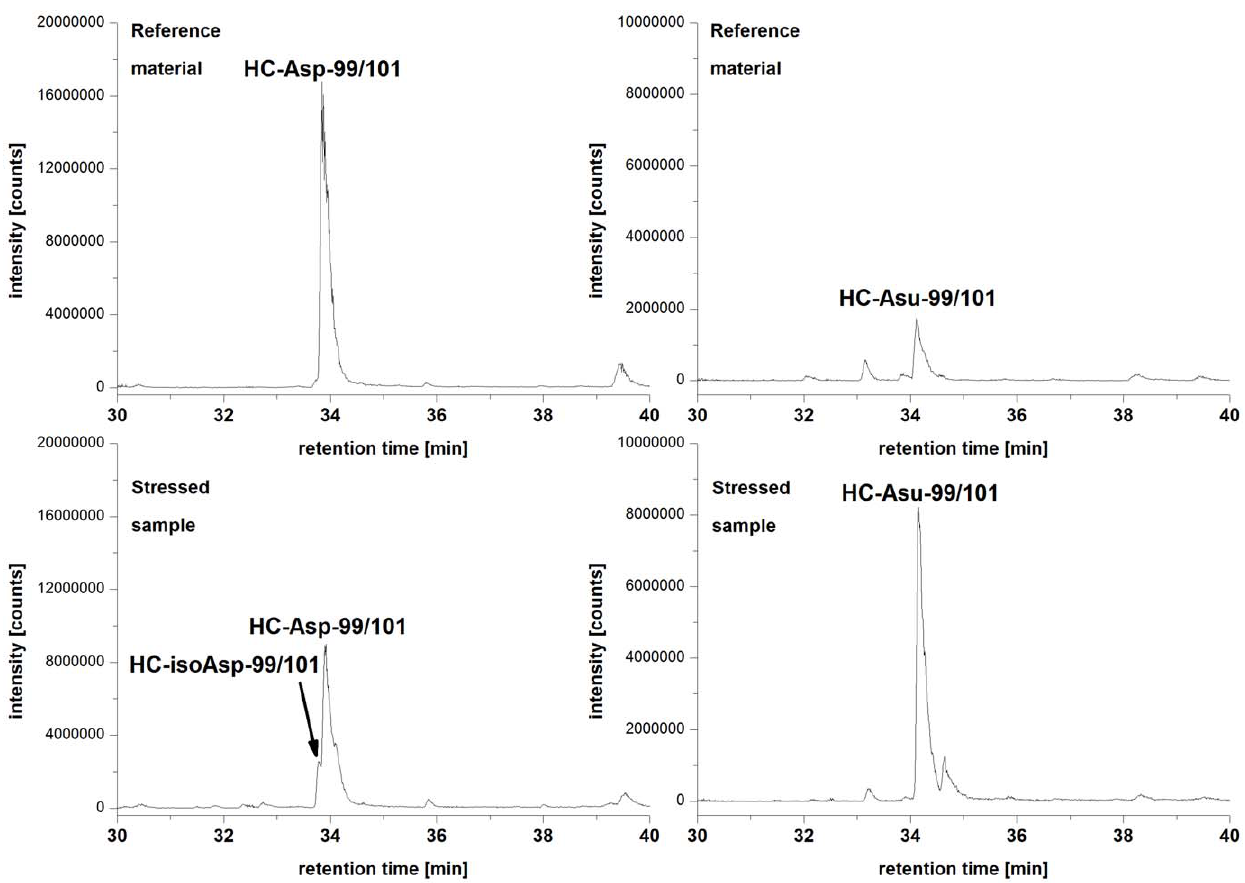
Figure 6. Specific ion chromatograms (SICs) of Mab1 peptides containing LC-Asx-99/101. M=5464.46 Da (z=3, 4, and 5) (HC-Asp-99/101; HC-iso-Asp-99/101) and M=5446.45 Da (z=3, 4, and 5) (HC-Asu-99/101) from the Mab1 reference material and a stressed sample (stored at 40 u C for 2 month).